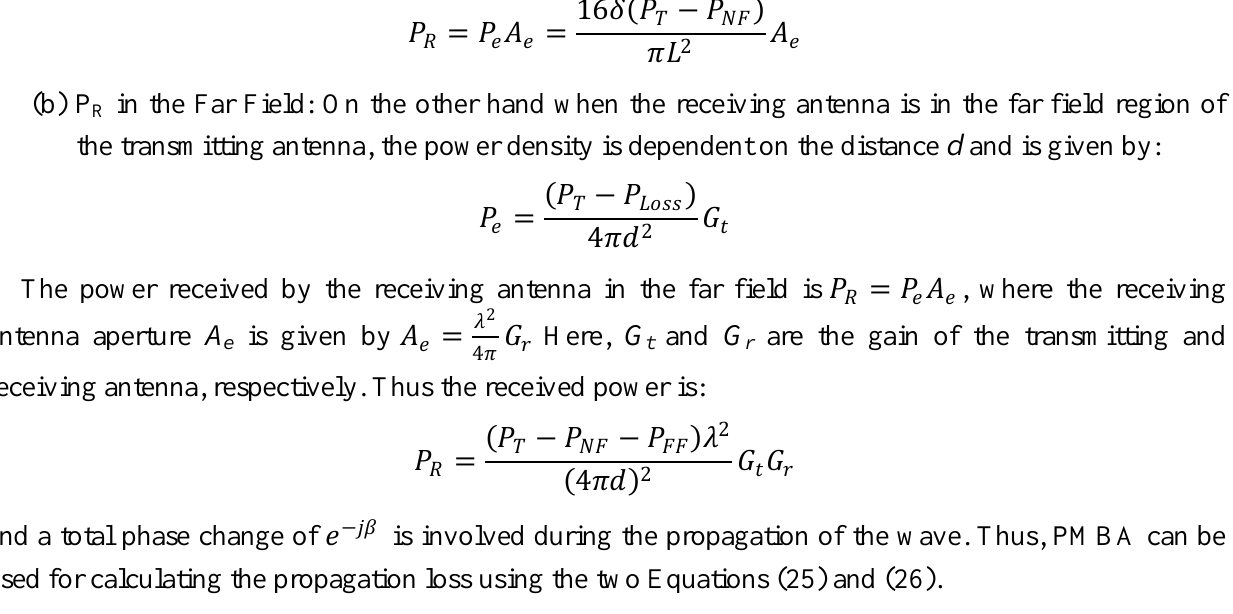
Figure 11. PMBA (tissue medium) and Freespace Pathloss at 2.4